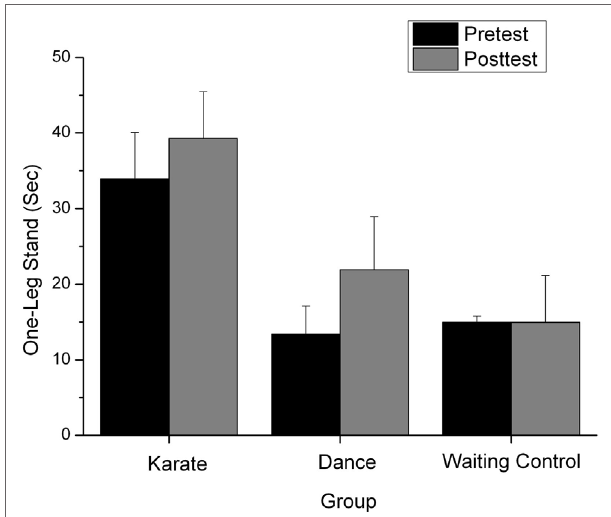
FigUre 2 | Performance in the one-leg stand (measured in seconds) in the (in the pretest and posttest) for the karate, dance, and waiting control group.